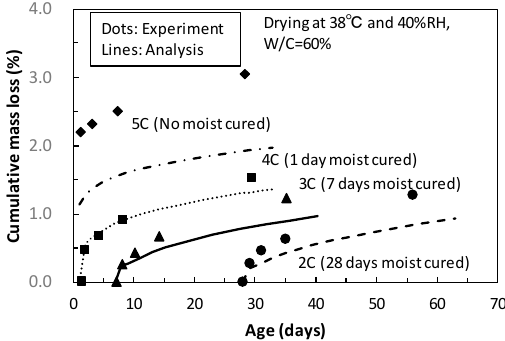
Figure 25. Comparison of weight loss based on the extensive model (W/C = 60%) [29].